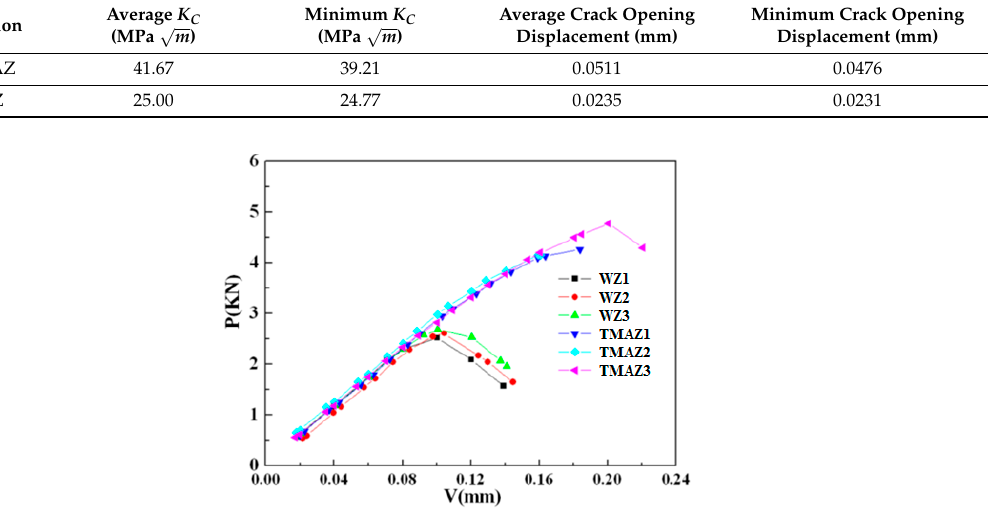
Figure 12. Load-displacement curve of the crack opening displacement at in different zones of the joint. Table 2. Fracture toughness of the joint.